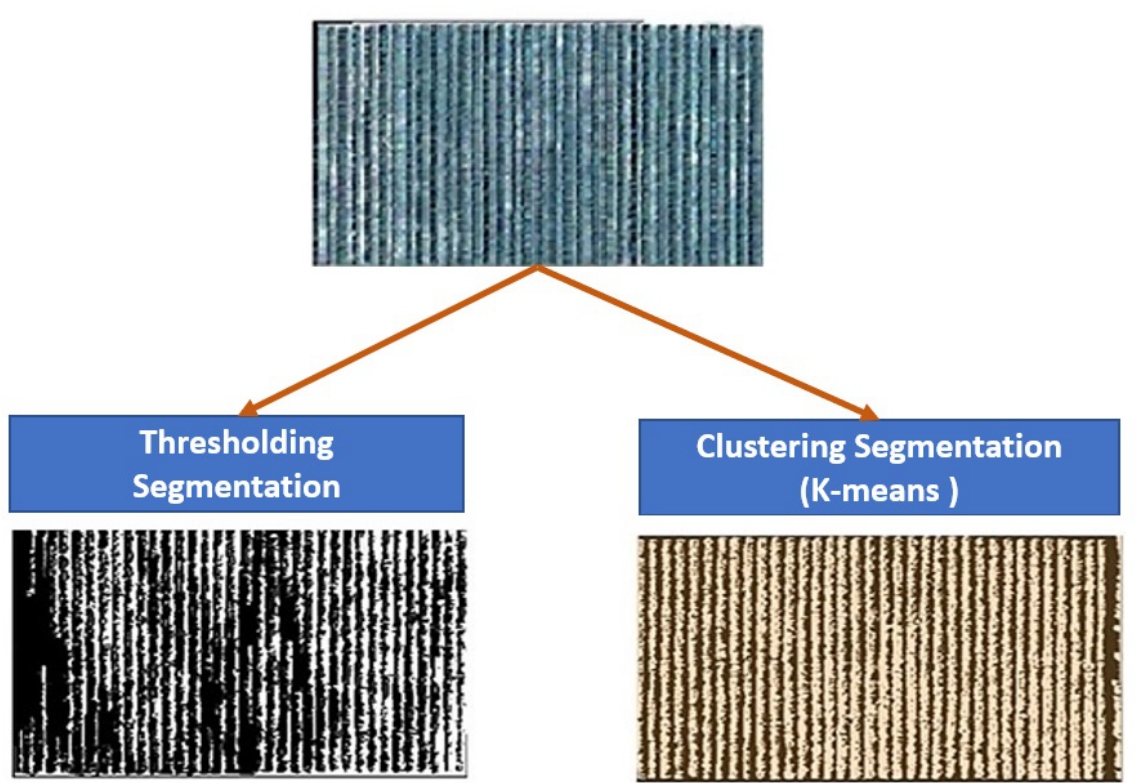
Figure 5. Example of tree identification using thresholding and clustering (k-means)